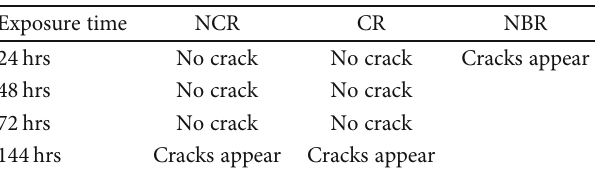
Table 6: Ozone resistance of vulcanizates of acrylonitrile- chloroprene rubber (NCR), chloroprene rubber (CR), and nitrile rubber